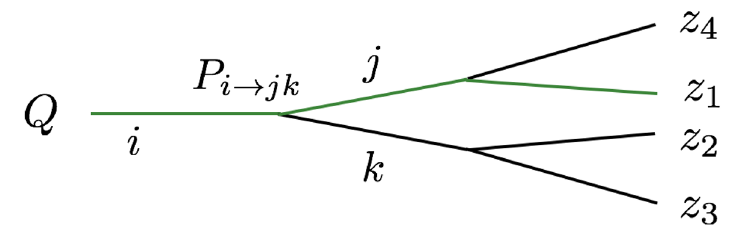
Figure 2 . Illustration of an exemplary branching tree: Starting from parton i at the scale Q , four partons/jets are produced which carry a momentum fraction z relative to the initial scale. In order n to determine the correct path (green) that leads to the leading jet, we need to know the momentum fractions and leading jet functions of each branch at a given splitting i → jk . This results in a non-linear evolution equation for observables involving leading jets. Instead, for inclusive jets we only need to know the final momentum fractions z of each jet irrespective of the they compare to the rest of the event since we sum over all